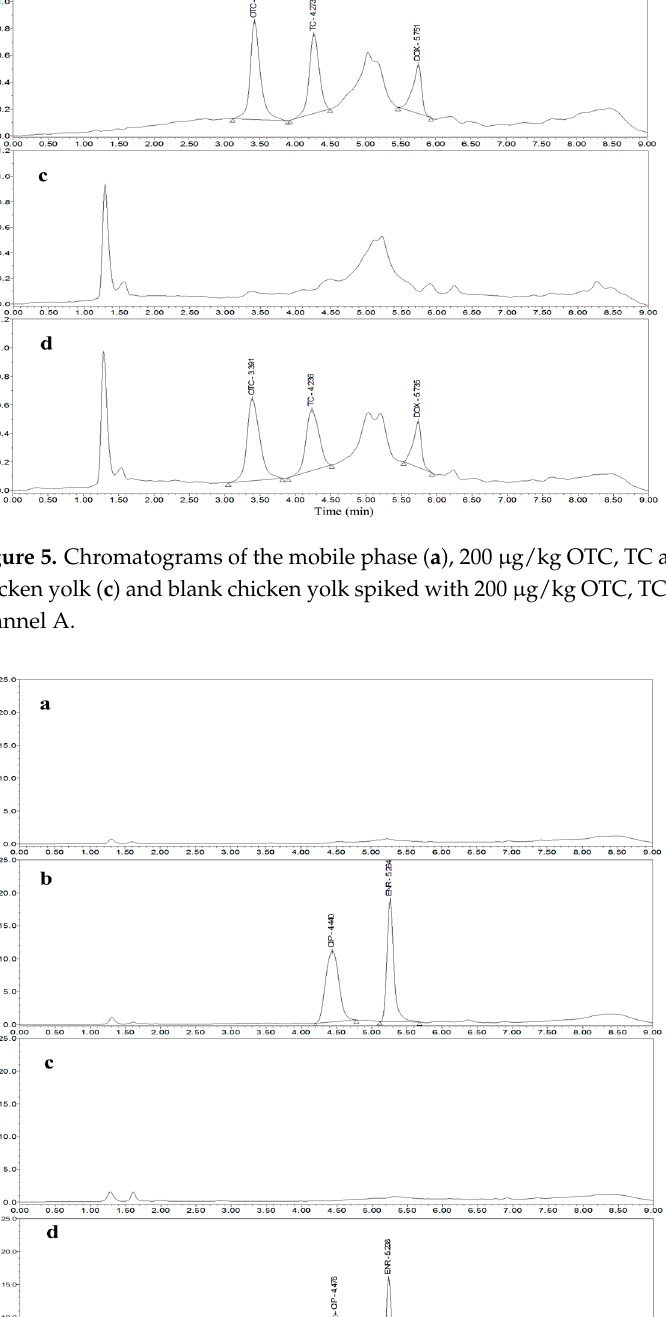
Figure 6. Chromatograms of the mobile phase ( a ), 50 μ g/kg CIP and 25 μ g/kg ENR standards ( b ), blank chicken yolk ( c ) and blank chicken yolk spiked with 50 μ g/kg CIP and 25 μ g/kg ENR standards ( d ) from channel B.